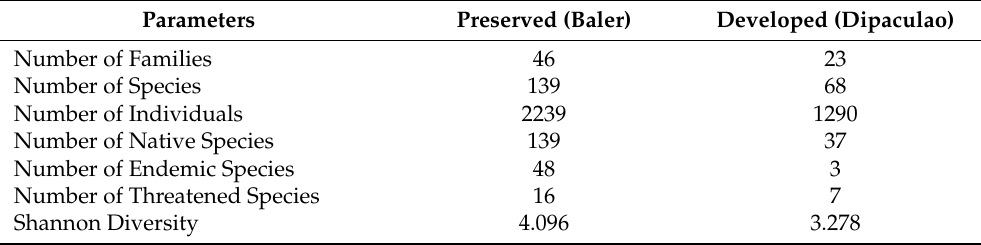
Table 1. Values of diversity and importance parameters of trees in Baler and Dipaculao. Parameters Preserved (Baler) Developed (Dipaculao) Number of Families 46 23 Number of Species 139 68 Number of Individuals 2239 1290 Number of Native Species 139 37 Number of Endemic Species 48 3 Number of Threatened Species 16 7 Shannon Diversity 4.096